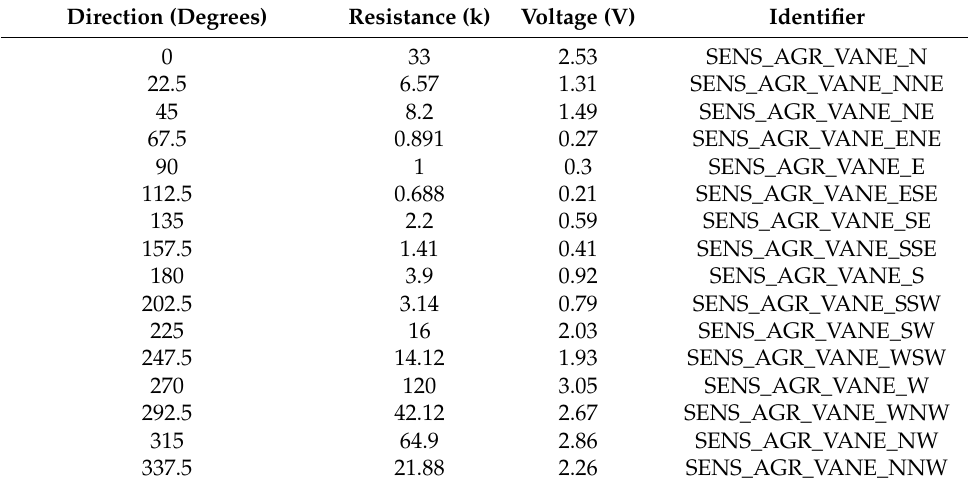
Table 7. Wind direction value